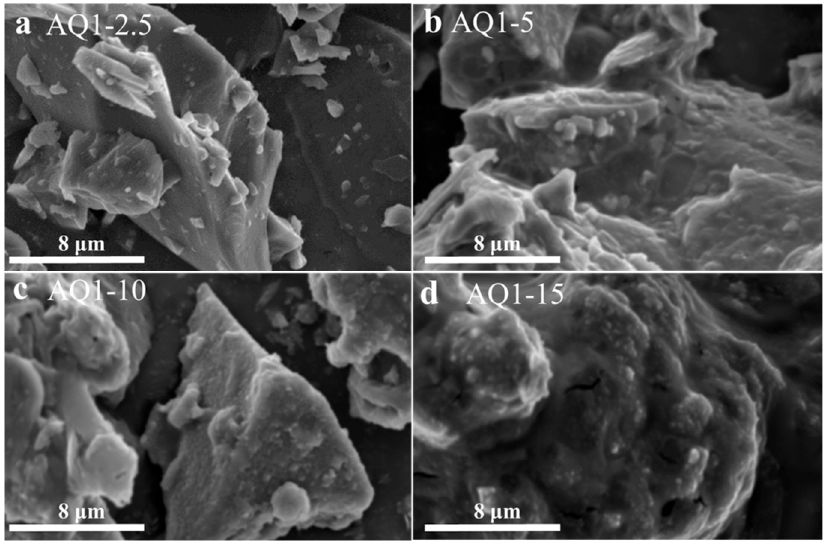
Figure 6. SEM images of quartz-1 activated with various content of NaOH: ( a ) AQ1-2.5, ( b ) AQ1-5, ( c ) AQ1-10 and ( d ) AQ1-15.